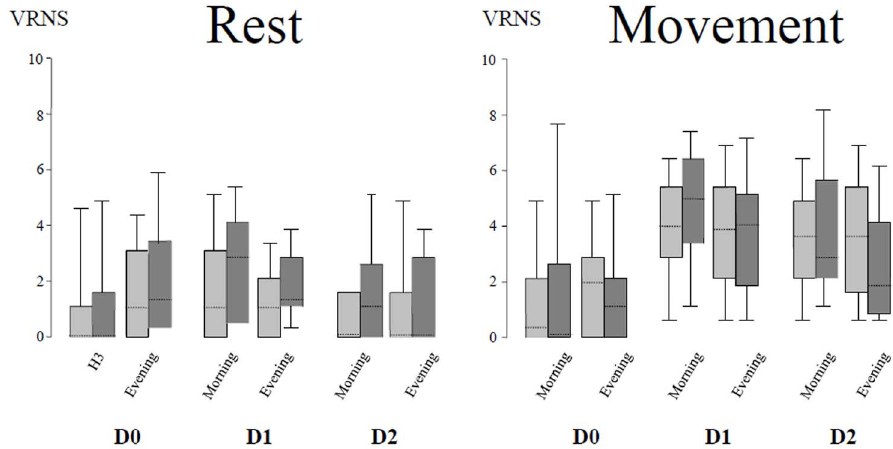
Figure 2. Pain scores at D0 (3rd postoperative hour and evening), D1 (morning and evening) and D2 (morning and evening). Results are represented by box plot. The horizontal solid line gives the median value and the upper and lower limit give the interquartile range. At last, the 5 and 95th percentiles correspond to the limit of the whiskers. Left panel: pain scores at rest. Right panel: pain scores during mobilization. VRNS: verbal response numerical scale pain score.